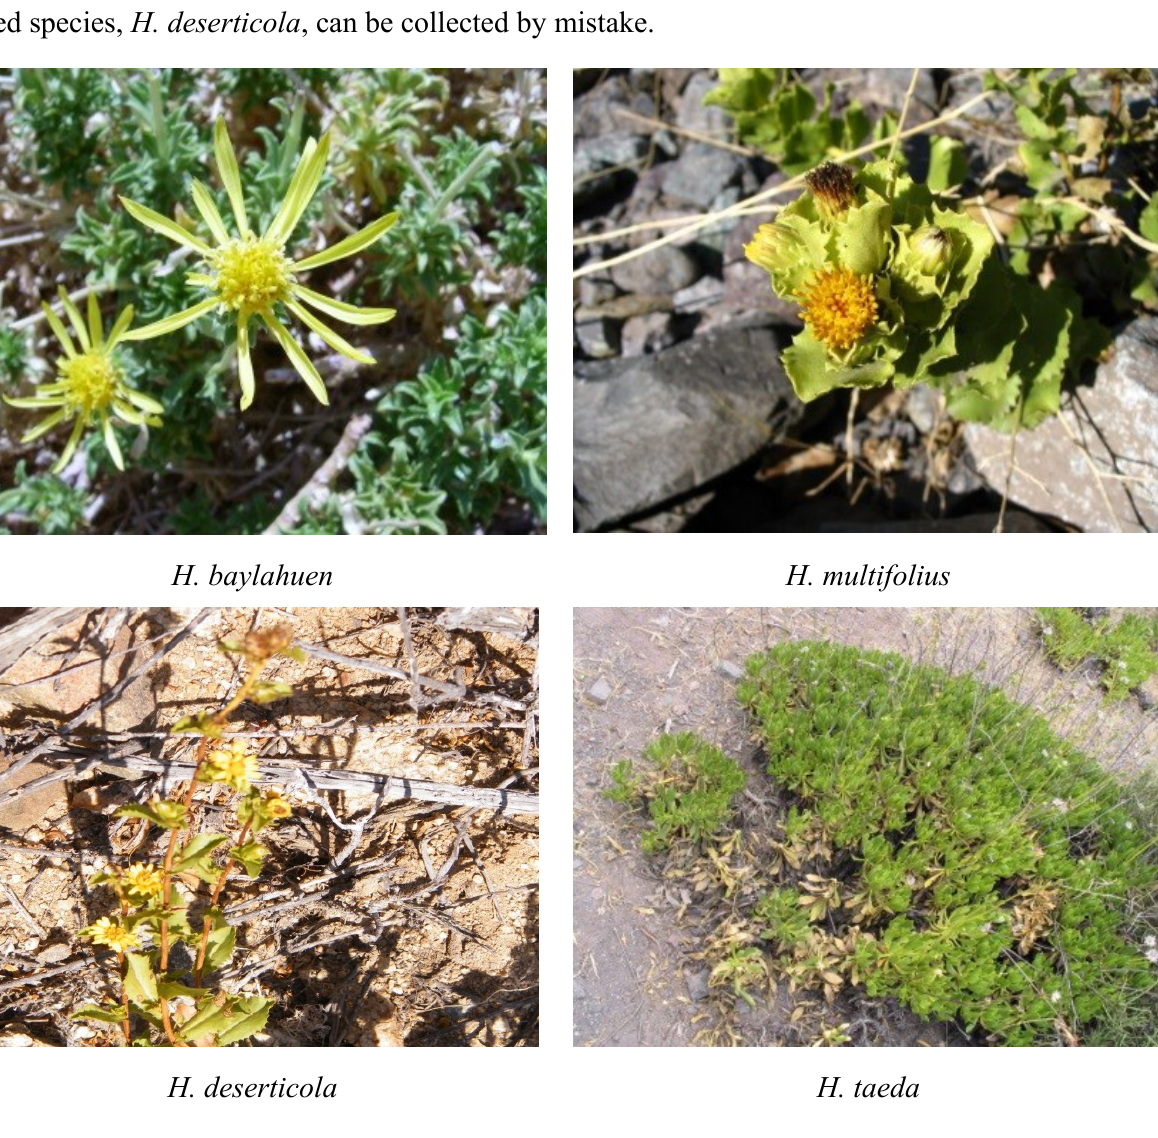
Figure 1. Chilean Haplopappus spp. belonging to the “baylahuen” complex growing in their natural